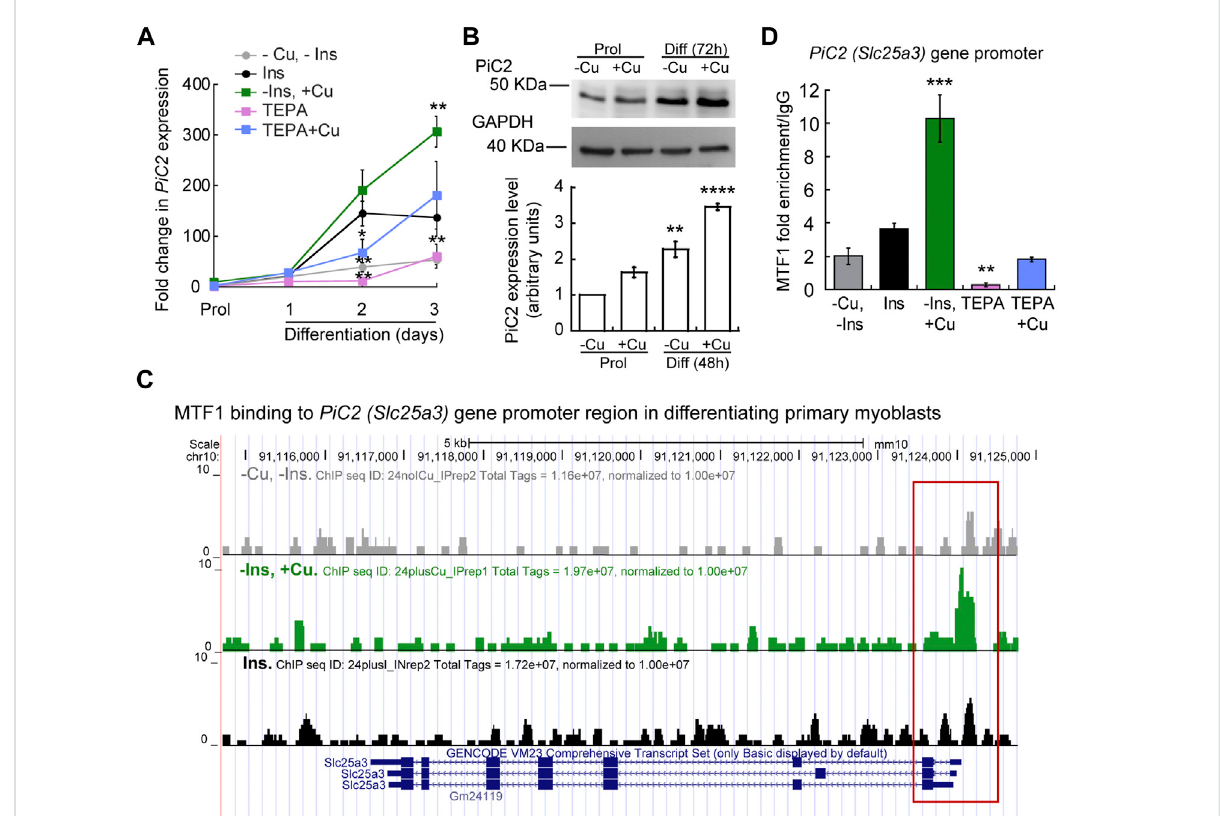
FIGURE 2 mPic2 isatargetgeneofMTF1indifferentiatingprimarymyoblasts,andCupromotesthisbinding. (A) mRNAlevelsof mPiC2 inproliferatingand differentiating primary myoblasts. mPic2 expression was measured by qPCR. Values normalized to Ef1 α and non-differentiated (Prol) controls, n = 3. (B) Representative western blot (top) and quanti fi cation (bottom) of proliferating (48 h) and differentiating (72 h) primary myoblasts grown in the presence or absence of Cu. Values normalized to GAPDH and non-treated Prol controls, n = 3. (C) Genome browser tracks of ChIP-seq experiments assessing MTF1 binding to the mPic2 promoter.Promoter region of mPic2 shown inred box. (D) ChIP-qPCR validation ofMTF1 binding the mPic2 promoter region. MTF1 enrichment at the mPic2 promoter was assessed by ChIP-qPCR, n = 3. All values are reported as means ± SEM. Signi fi cance was determined by two-way ANOVA; ** p < 0.01 and *** p < 0.001 compared to cells differentiated with insulin. Abbreviations used are: cells differentiated in the absence of insulin and copper (-Ins, − Cu), with insulin (Ins), of insulin and 30 µM CuSO 4 (-Ins, +Cu), with the 30 µM of the Cu-chelator TEPA (TEPA), and with 30 µM of TEPA supplemented with 30 µM CuSO 4 (TEPA +